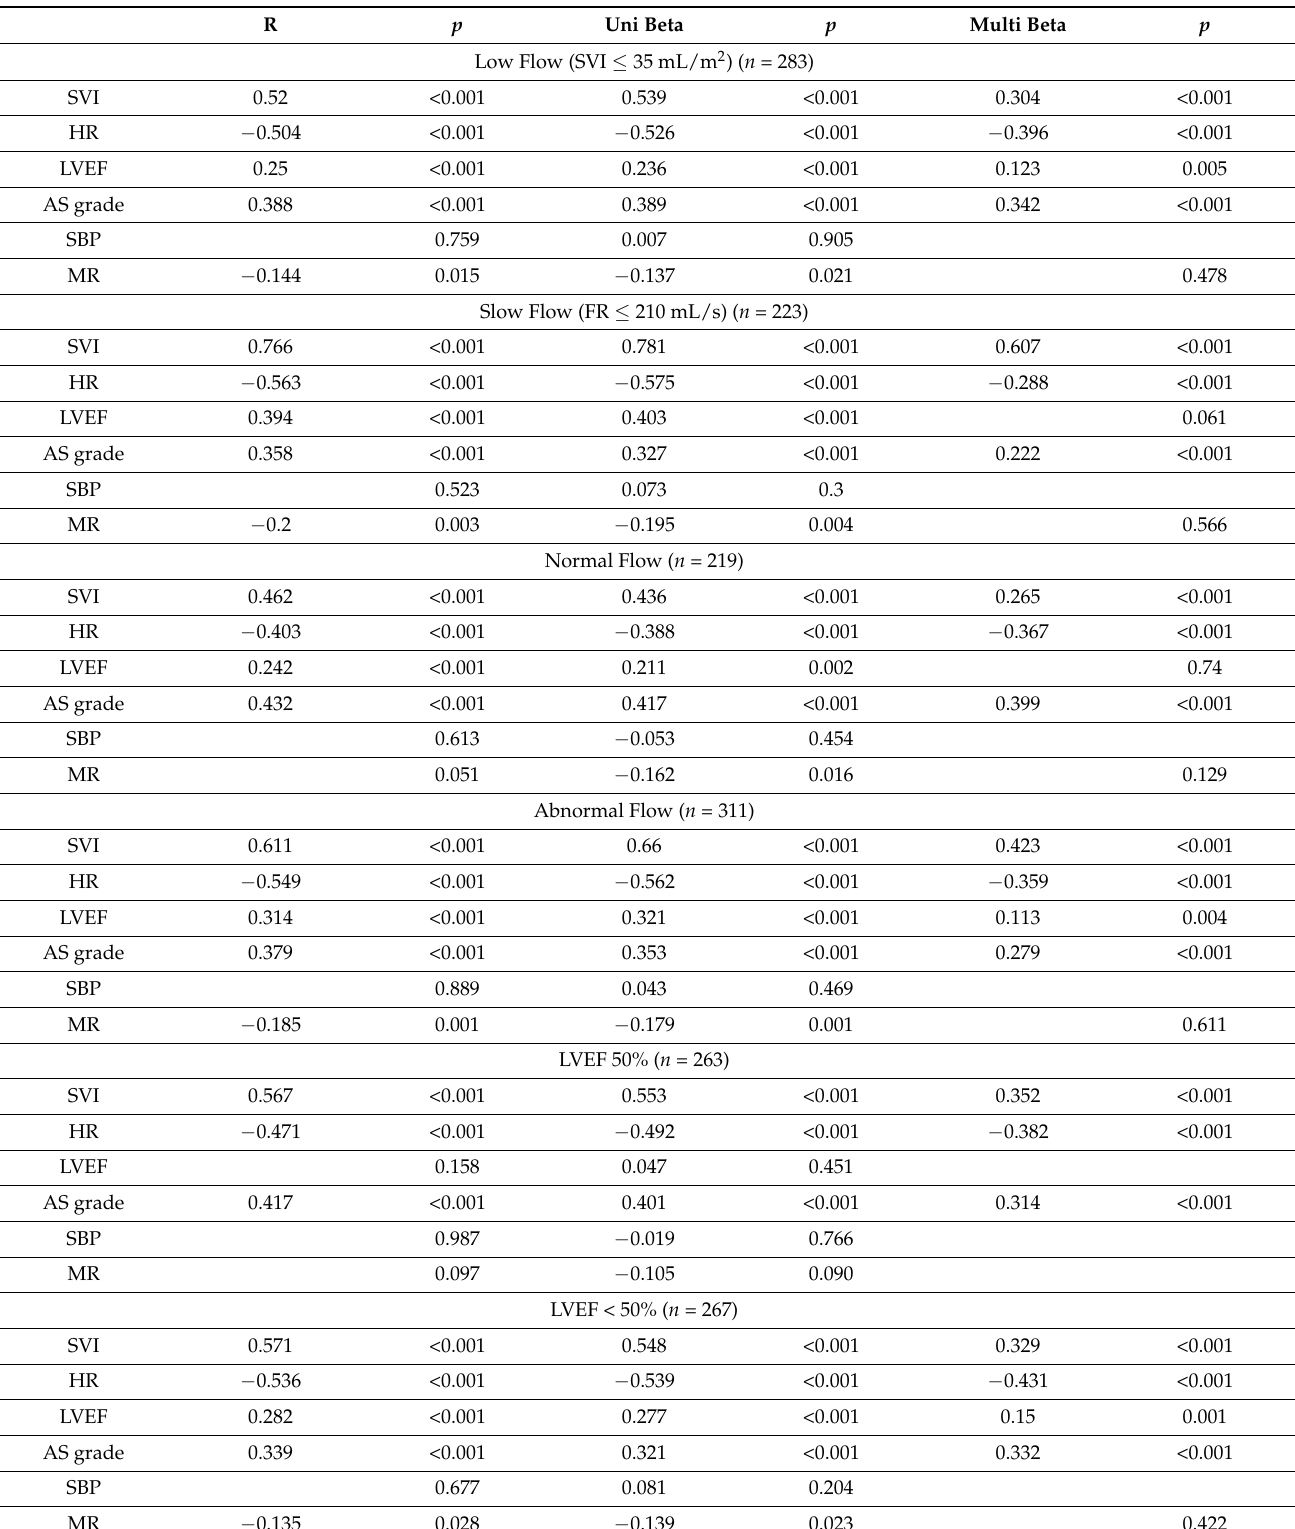
Table 4. Flow and LVEF subgroup